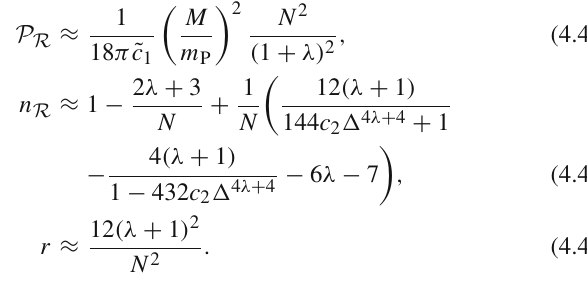
Fig. 8 We compare the theoretical predictions in the ( r − n s ) plane for different values of λ using (cid:23) (cid:25) = 100 , c 2 = 2 × 10 − 12 , N = 60 (left panel) and (cid:23) (cid:25) = 100 , c 2 = 3 . 25 × 10 − 15 , N = 70 (right panel) with Planck’18 results for TT, TE, EE, +lowE+lensing and